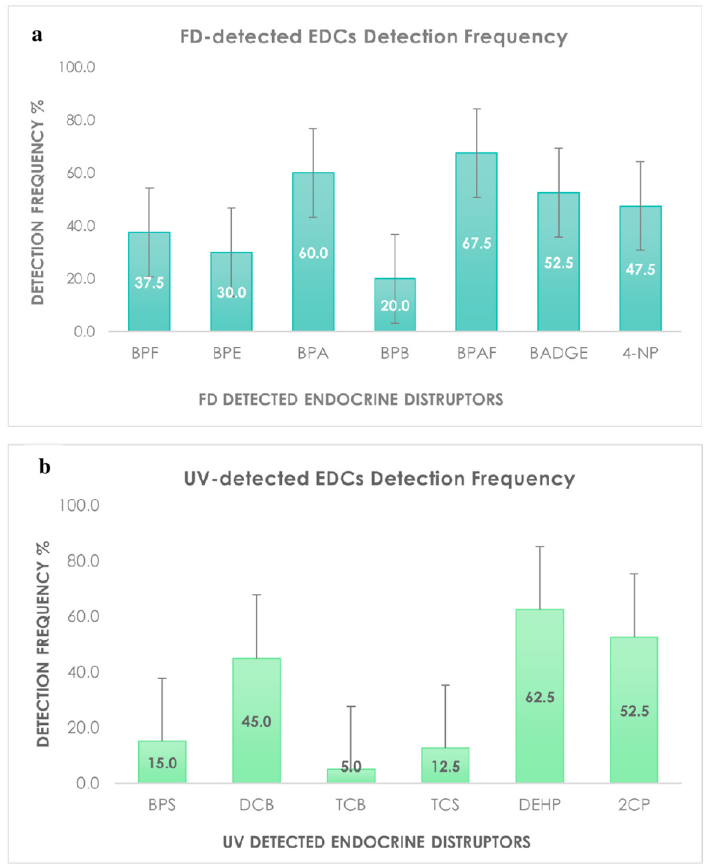
Figure 2. Detection frequency of FD ( a ) and UV ( b ) detected EDCs.